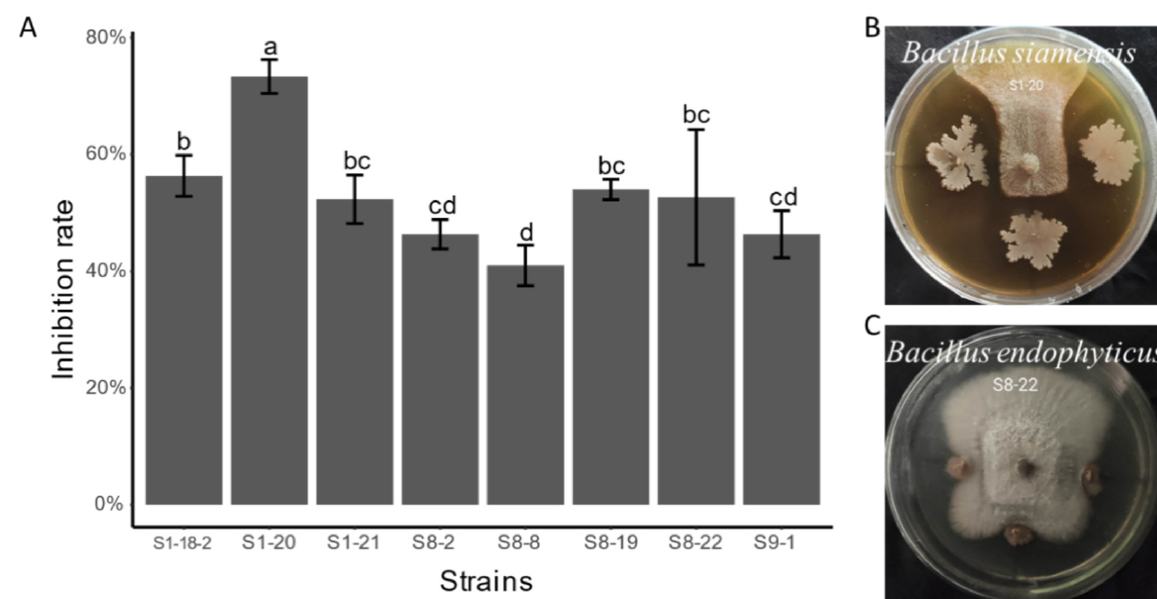
Figure 6. Screening results of endophytic bacterial isolates against pathogenic fungi of apple canker ( Valsa mali ), ( A ): bar chart of inhibition rate of endophytic bacteria against Valsa mali , ( B ): antagonistic effect picture of isolate S1-20, ( C ): antagonistic effect picture of isolate S8-22. The LSD test was used to check whether there was a significant difference in the inhibition rate among the different endophytic bacterial isolates. There were significant differences in the inhibition rate of endophytic bacterial isolates labeled with different letters. There was no significant difference in the inhibition rate between endophytic bacterial isolates labeled with repeated letters.